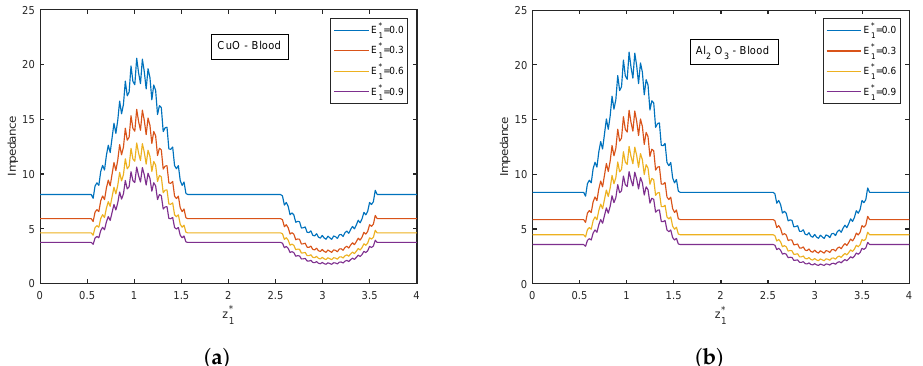
Figure 16. Impedance profiles of electric field parameter E ∗ nanoparticles at t ∗ = 1.2. 1